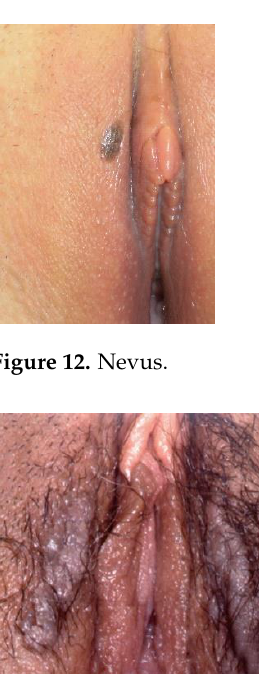
Figure 11. Hyperpigmentation.